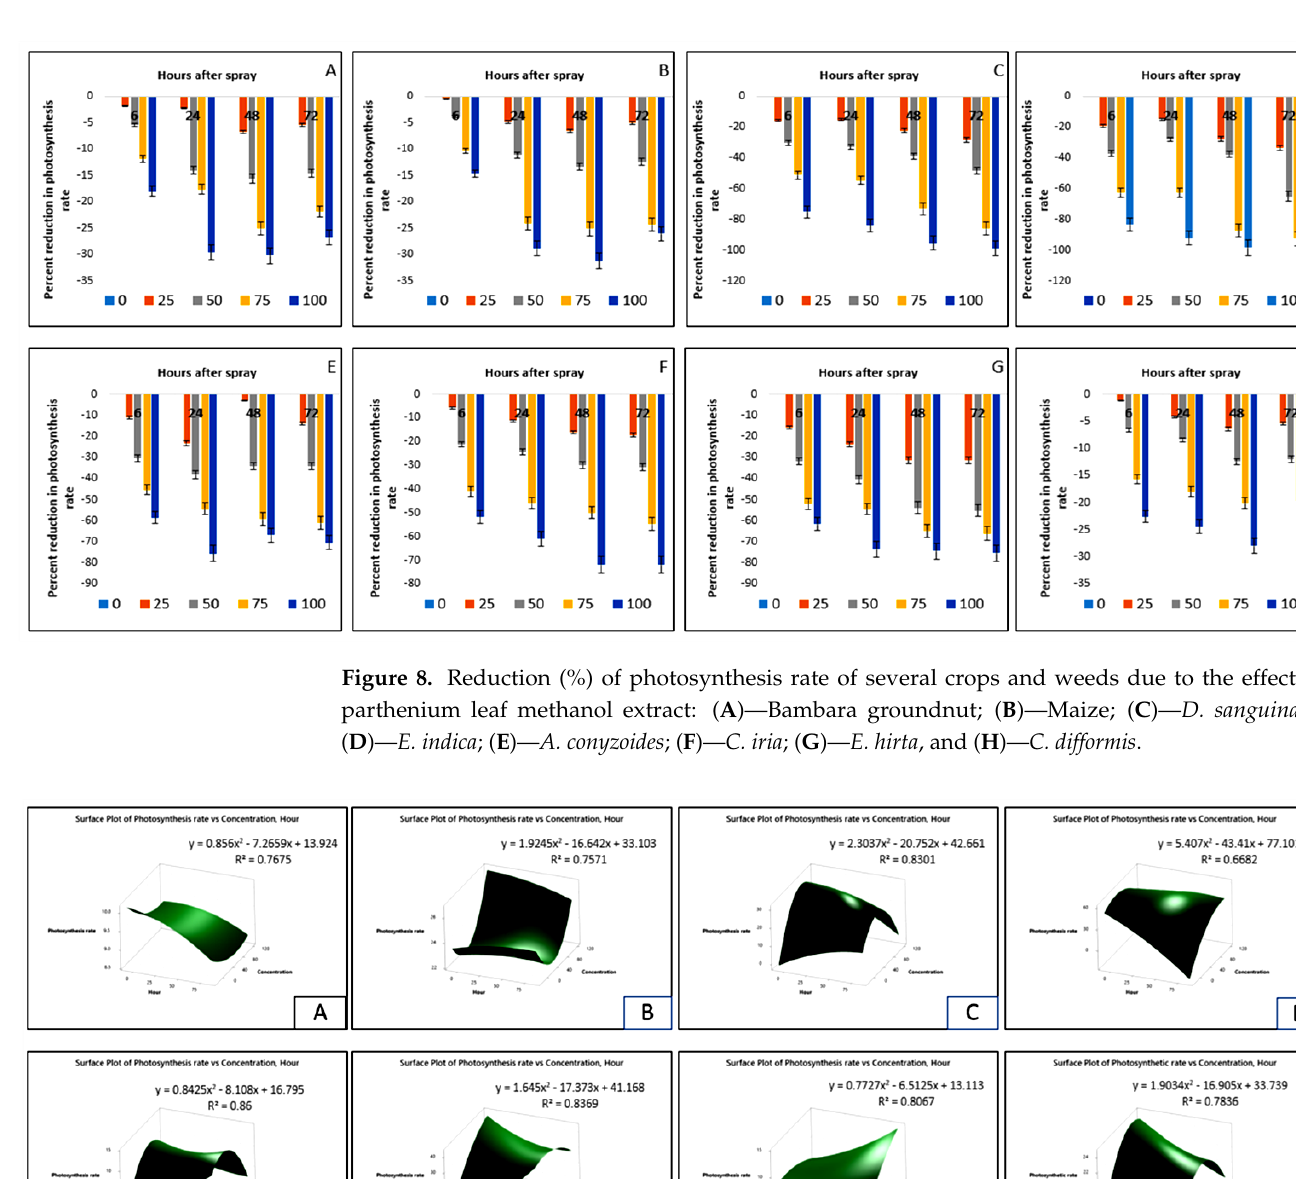
12 of 35 Figure 7. Reduction (%) of carotenoids due to the effect of parthenium leaf methanol extract on several crops and weeds: ( A ) -Bambara groundnut; ( B ) -Maize; ( C ) - D. sanguinalis ; ( D ) - E. indica ; ( E ) - A. conyzoides ; ( F ) - C. iria ; ( G ) - E. hirta , and ( H ) - C. difformis . 2.7. Effect on Photosynthesis Rate of Crops and Weeds